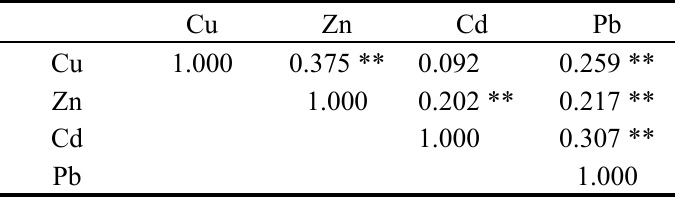
Table 5. Correlation analysis of the dependent